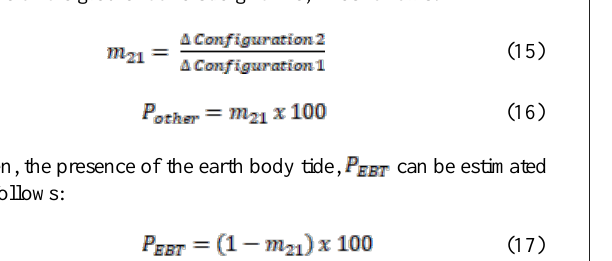
Figure 5. The average of presence signals in GPS observations at east